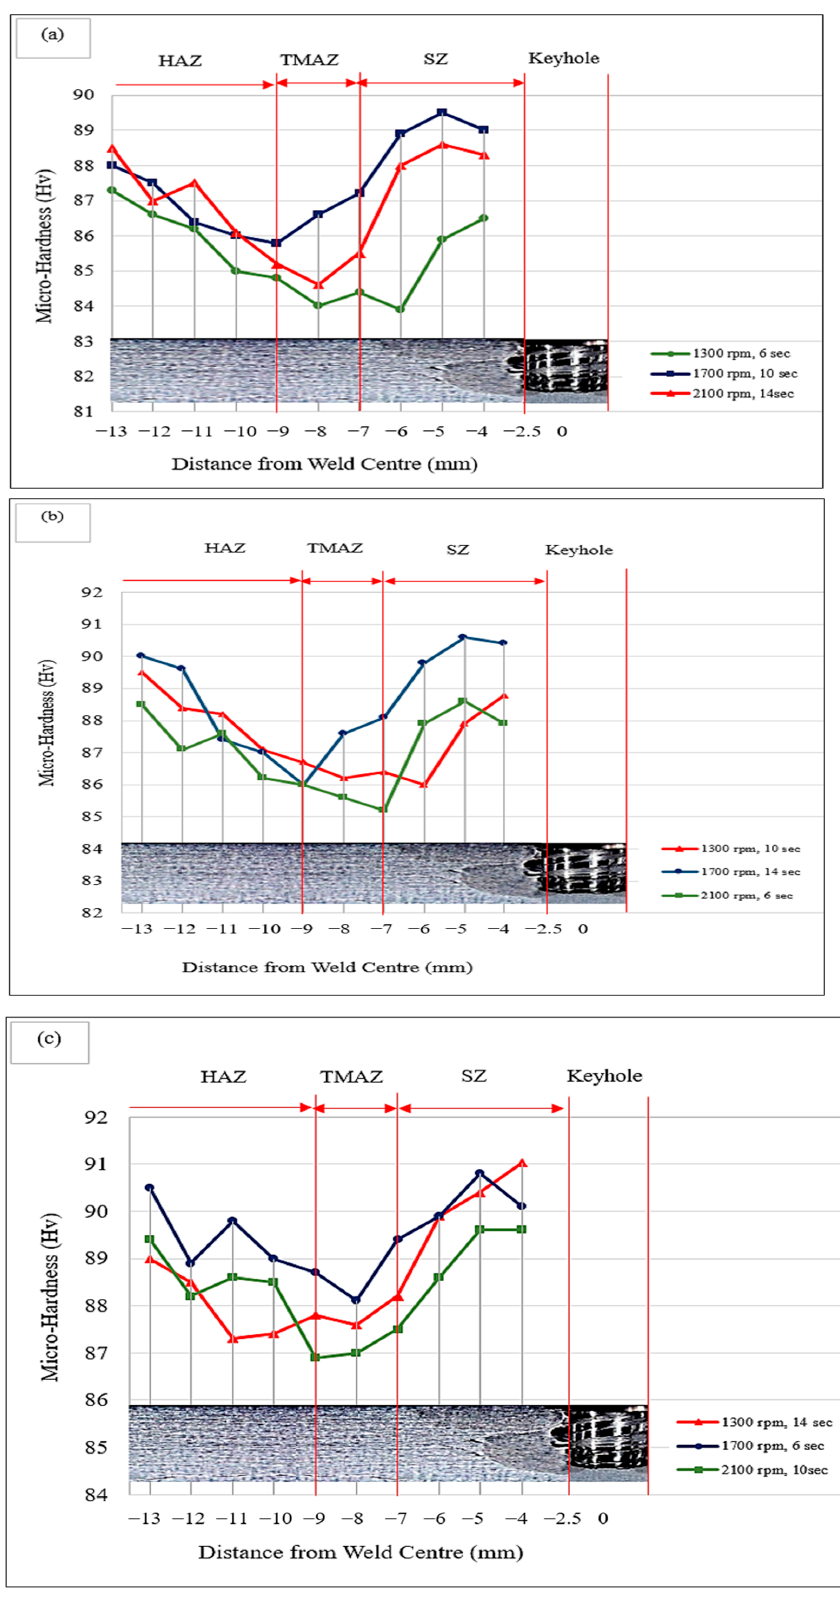
Figure 10. Micro-hardness profiles of samples obtained at ( a ) 2.5 mm guiding hole diameter, ( b ) 3.0 mm guiding hole diameter, and ( c ) 3.5 mm guiding hole diameter. ( b ) 3.0 mm guiding hole diameter, and ( c ) 3.5 mm guiding hole